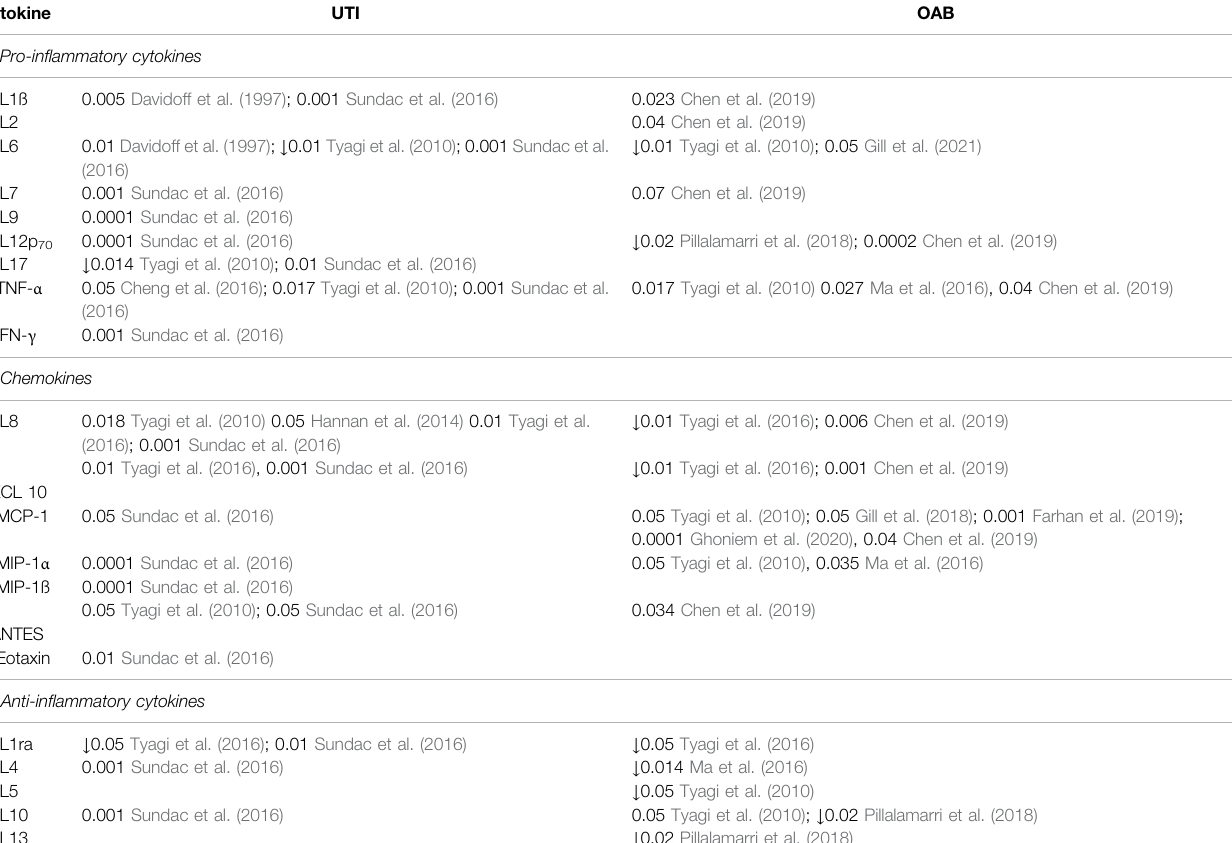
TABLE 1 | A summary of the literature reports of changes in the levels of urinary cytokines in adult patients with UTI or